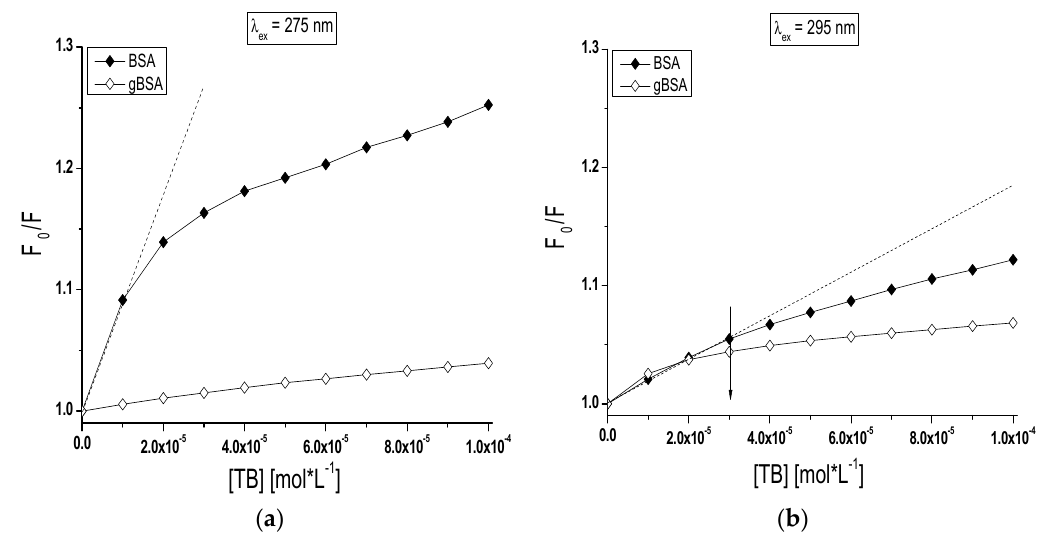
Figure 5. The Stern-Volmer plots of F 0 vs. (TB) (mol · L − 1 ) for TB-BSA ( (cid:7) ) and TB-gBSA ( ♦ ) complex: ( a ) λ ex = 275 nm; and ( b ) λ ex = 295 nm; T = 309 K. The error bars are smaller than the symbols.